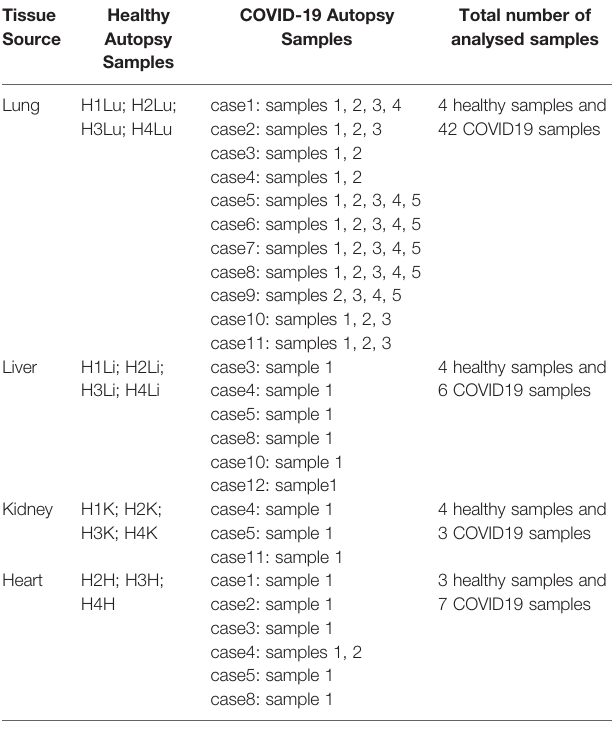
TABLE 1 | List of analyzed healthy and COVID-19 autopsy samples retrieved from the datasets GSE112356 and GSE150316 deposited in GEO. Tissue Healthy Source